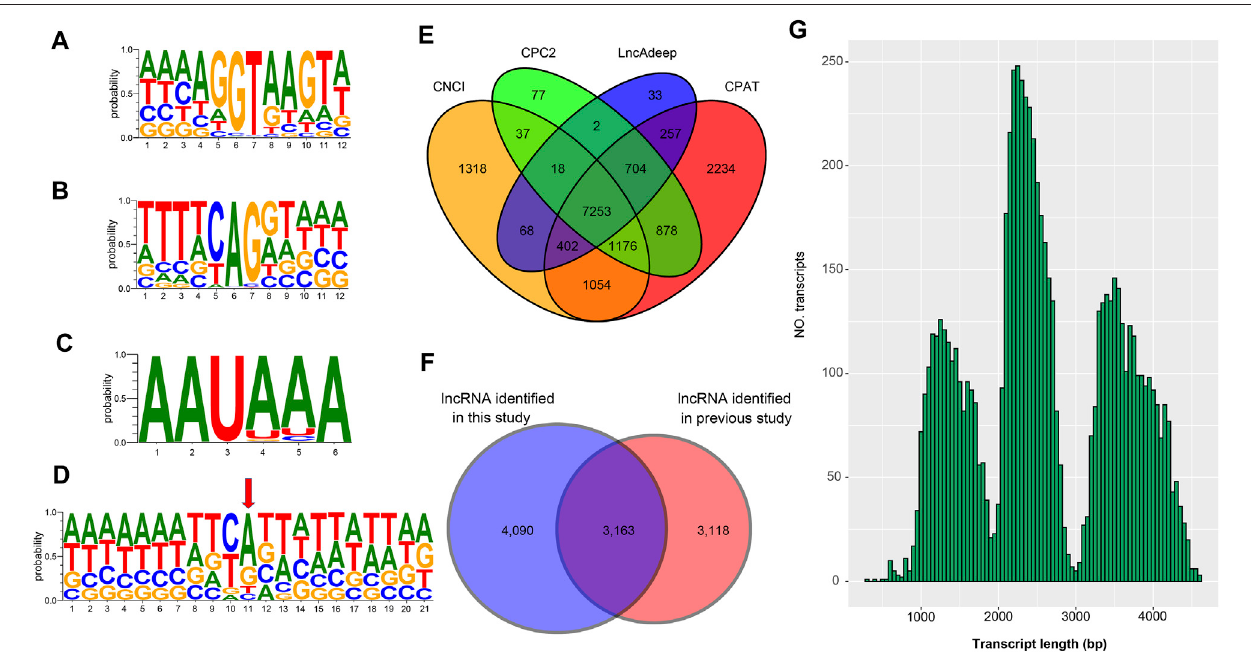
FIGURE 2 | Analysis of splice junctions, poly(A) signal sites, TSS site, and lncRNA ( A ) The mononucleotide variant distributions of the donor site ( B ) The mononucleotide variant distributions of the acceptor sites ( C ) The mononucleotide variant distributions of the poly(A) site ( D ) The mononucleotide variant distributions of the TSS sites (E) Venn diagram of lncRNA identi fi cation by four methods including CNCI, CPC2, LncAdeep and CPAT ( F ) The Venn diagram shows the comparative result of the lncRNA identi fi ed in this study and the previously reported LncRNAs ( G ) The length distribution of the lncRNAs identi fi ed in this study.